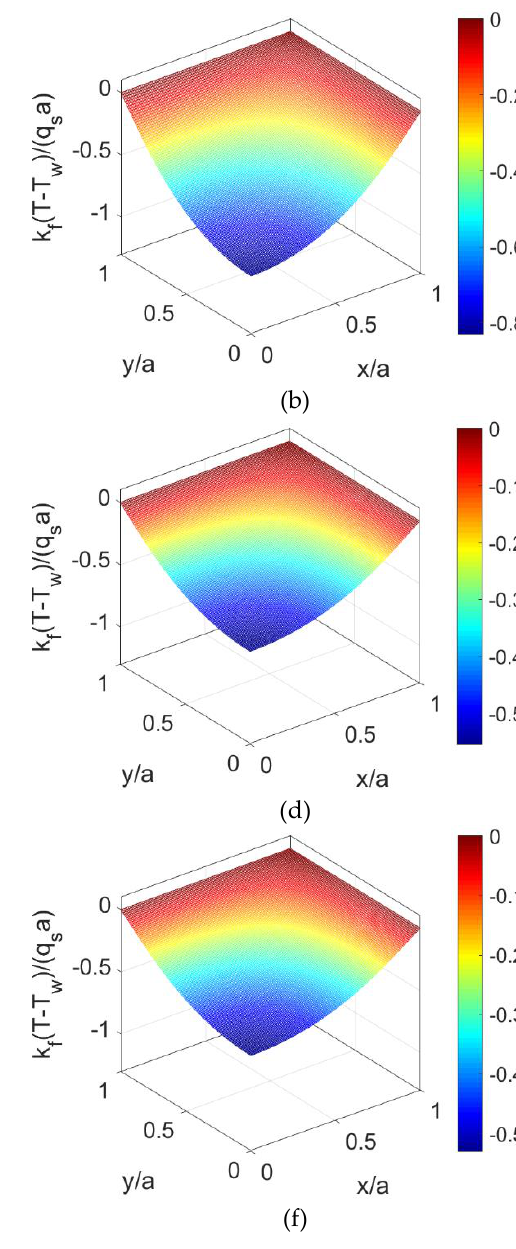
Figure 5. The dimensionless temperature distributions of shear thinning nanofluid, Newtonian nanofluid, and shear thickening nanofluid for different Joule heating parameters S when nanoparticle volume fraction is ϕ = 0.06: ( a ) n = 0.8, S = 0; ( b ) n = 0.8, S = 3; ( c ) n = 1.0, S = 0; ( d ) n = 1.0, S = 3; ( e ) n = 1.2, S = 0; ( f ) n = 1.2, S = 3.